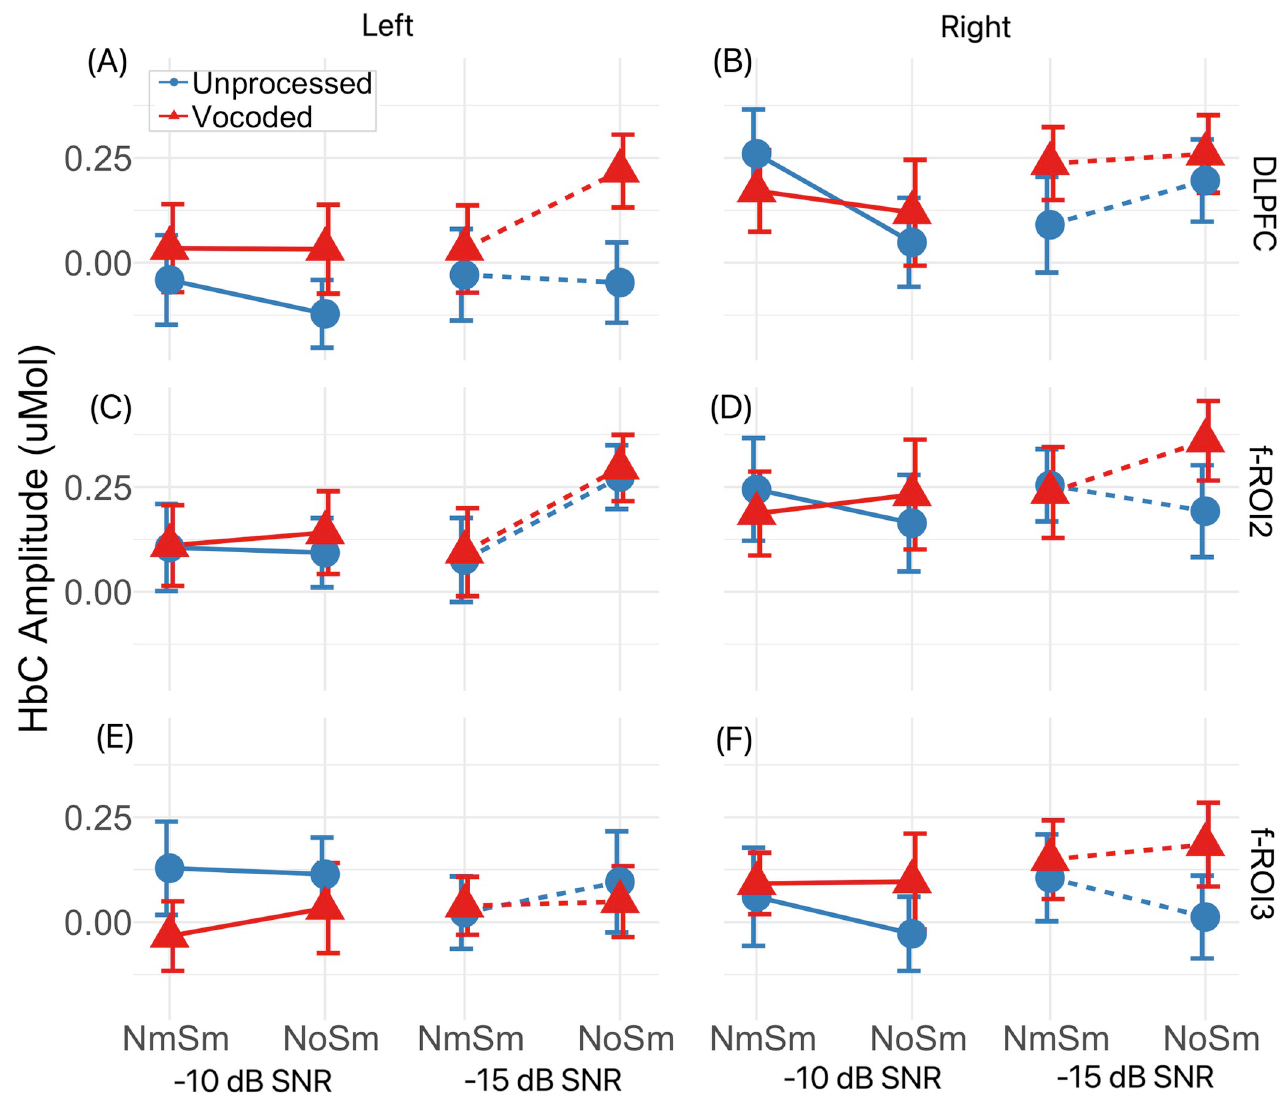
Fig 7. Δ HbC amplitudes in the three subregions within the LPFC on two hemispheres. different sub-regions were involved for effortful speech perception with varying configura- tions. Hence, we divided the LPFC into three sub-regions, i.e., DLPFC, f-ROI2, and f-ROI3, and attempted to explore fNIRS measures in these regions on both hemispheres. Our results showed a significant effect of speech type with greater Δ HbC amplitudes to vocoded versus unprocessed speech, and significant differences in responses between three subregions, with greater responses in the f-ROI2 compared to the DLPFC and f-ROI3. Further, DLPFC showed greater hemispherical differences compared to f-ROI3. However, there was no significant interaction between speech type � ROI. Our results did not demonstrate significantly different effects of SNR or masker condition between the three sub-regions, either. It is possible that there are no functional differences, and the three subregions in the current study (Fig 1B) still overlap and share common functions in the effortful speech perception with varying stimulus configurations. Each ROI consisted of three 3-cm channels and overlapped on the surface i.e.,